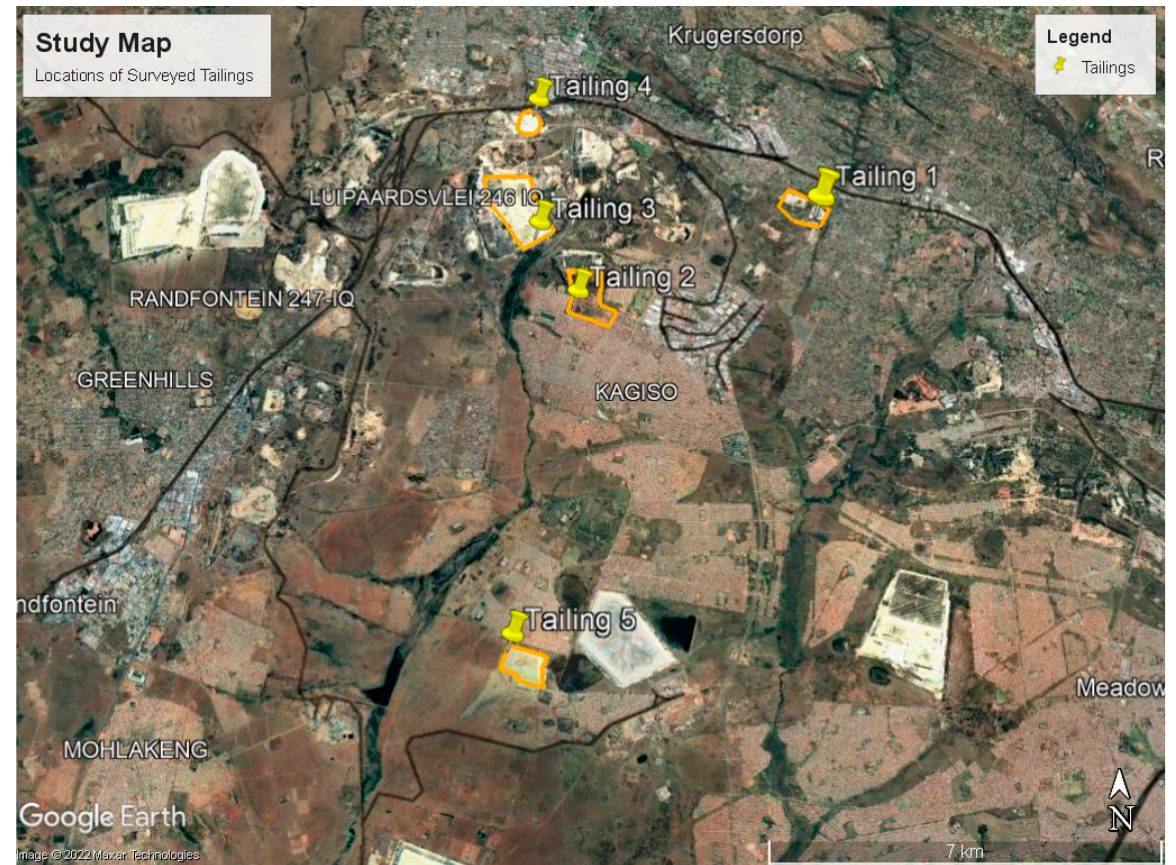
Figure 3. The locations of all the surveyed mine tailings in this study.